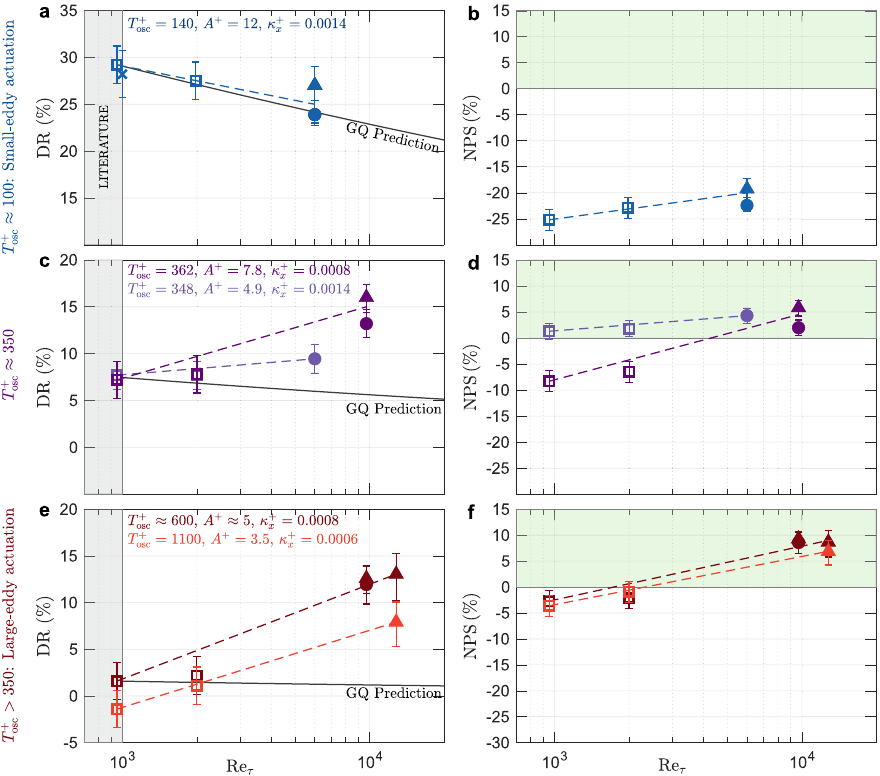
Fig. 3 Drag reduction and net power savings increase with friction Reynolds number far above predicted values when oscillatory surface actuation couples to large eddies. DR(%) and NPS(%) for small-eddy actuation ( a , b ) con fi rming an Re τ trend of DR predicted by the formulation of Gatti and Quadrio 13,GQ and resulting in negative NPS. In contrast, large-eddy actuation ( e , f ) leads to DR increase at higher Re τ (dark red) to 10 − 15%, ~ 10-fold greater than predicted and resulting in positive NPS ≈ 10%. c , d Trends of DR(%) and NPS(%) for an intermediate actuation corresponding to the large- (cid:4) 350. Open squares indicate large-eddy simulations (LES), circles indicate hot-wire anemometry experiments, triangles indicate drag scale cut-off T þ osc balance experiments and crosses indicate direct-numerical simulation (DNS) result of Gatti and Quadrio 13 . Error bars indicate one standard deviation estimated uncertainty ranges. Dashed lines connecting experimental and computational measurements are included as a visual aid only. See Supplementary Table 1 for details of the fl ow and